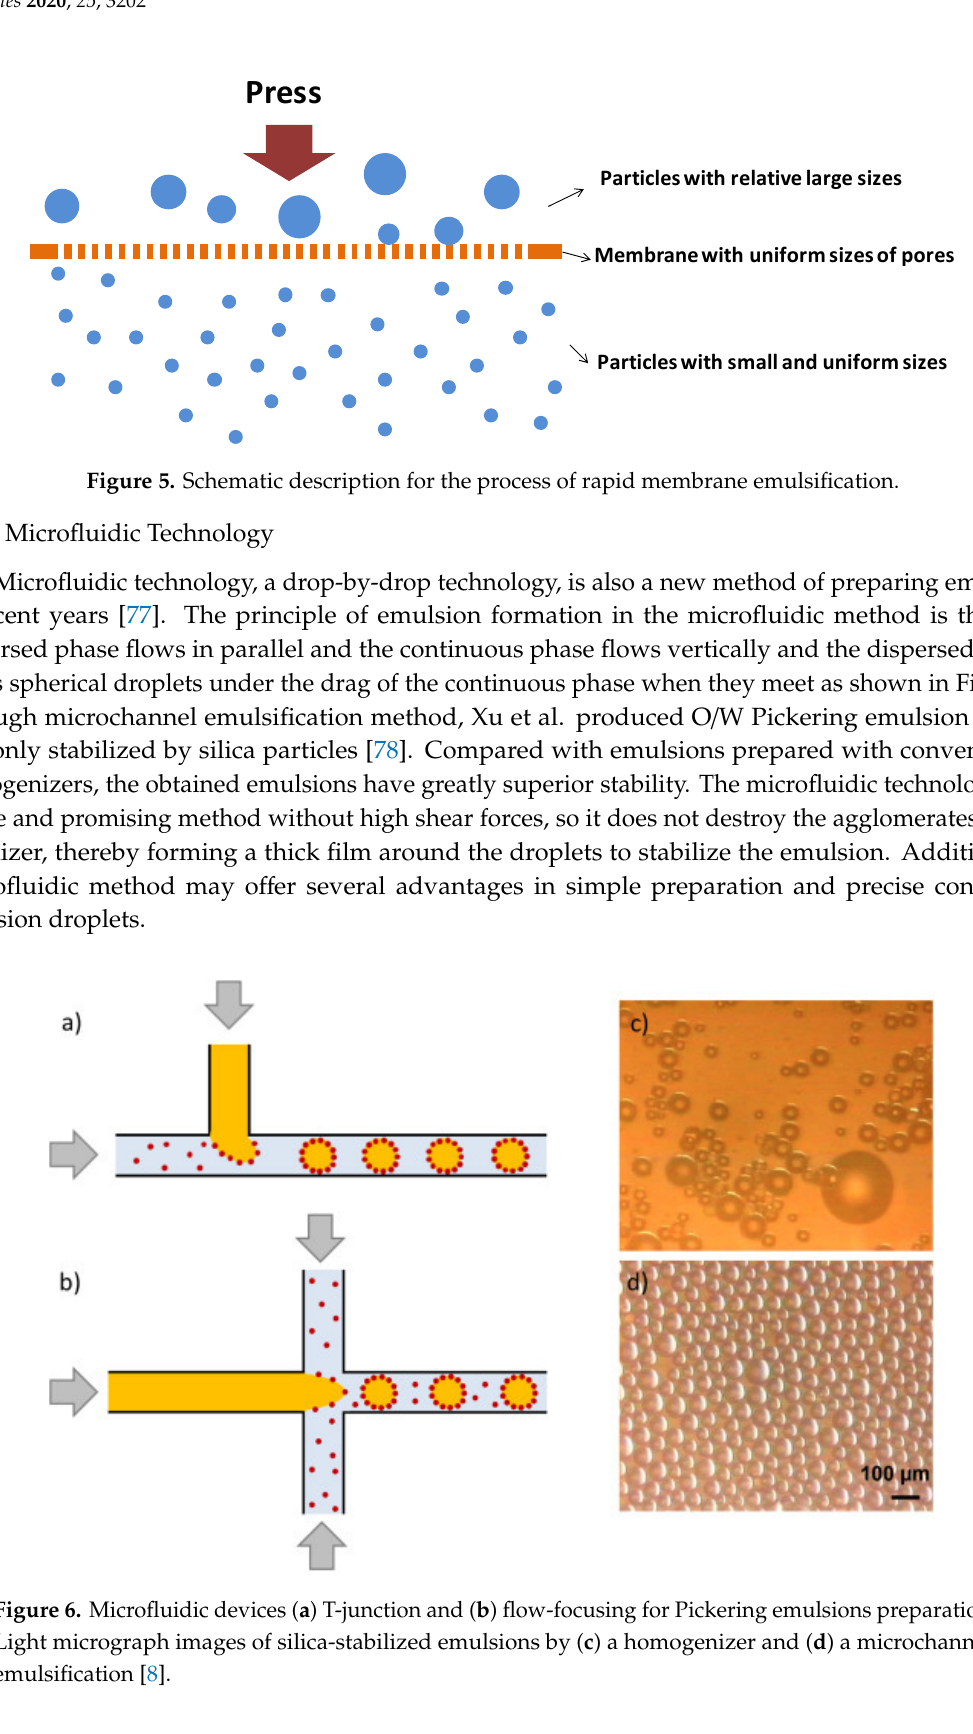
Figure 4. Schematic description of processes of direct membrane emulsification method.